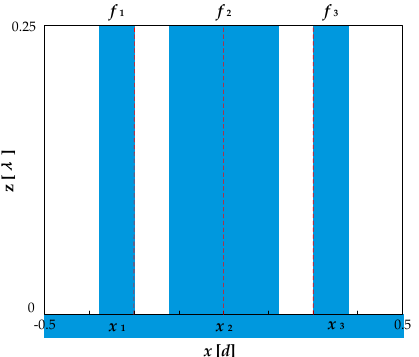
Figure 10. Grating structure with even diffraction orders eliminated when n = 3. According to Equation (10), the diffraction efficiency is expressed as: When N = 5 and h = λ /4, the grating structure is shown in Figure 11, and its structural parameters satisfy the following requirements.